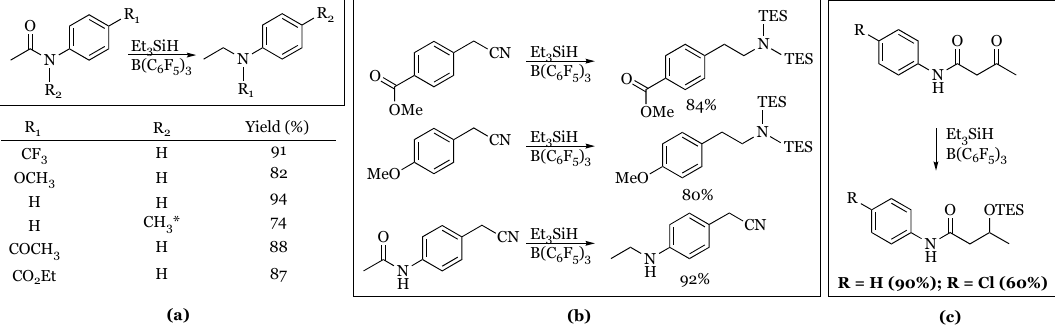
Figure 8. Selectivity experiments with various functional groups: ( a ) Reduction of acetanilide amides in the presence of ethers, ketone, and esters; ( b ) reduction of benzyl nitriles in the presence of ethers, esters; ( c ) acetoacetanilide reductions. *diethylsilane was used.